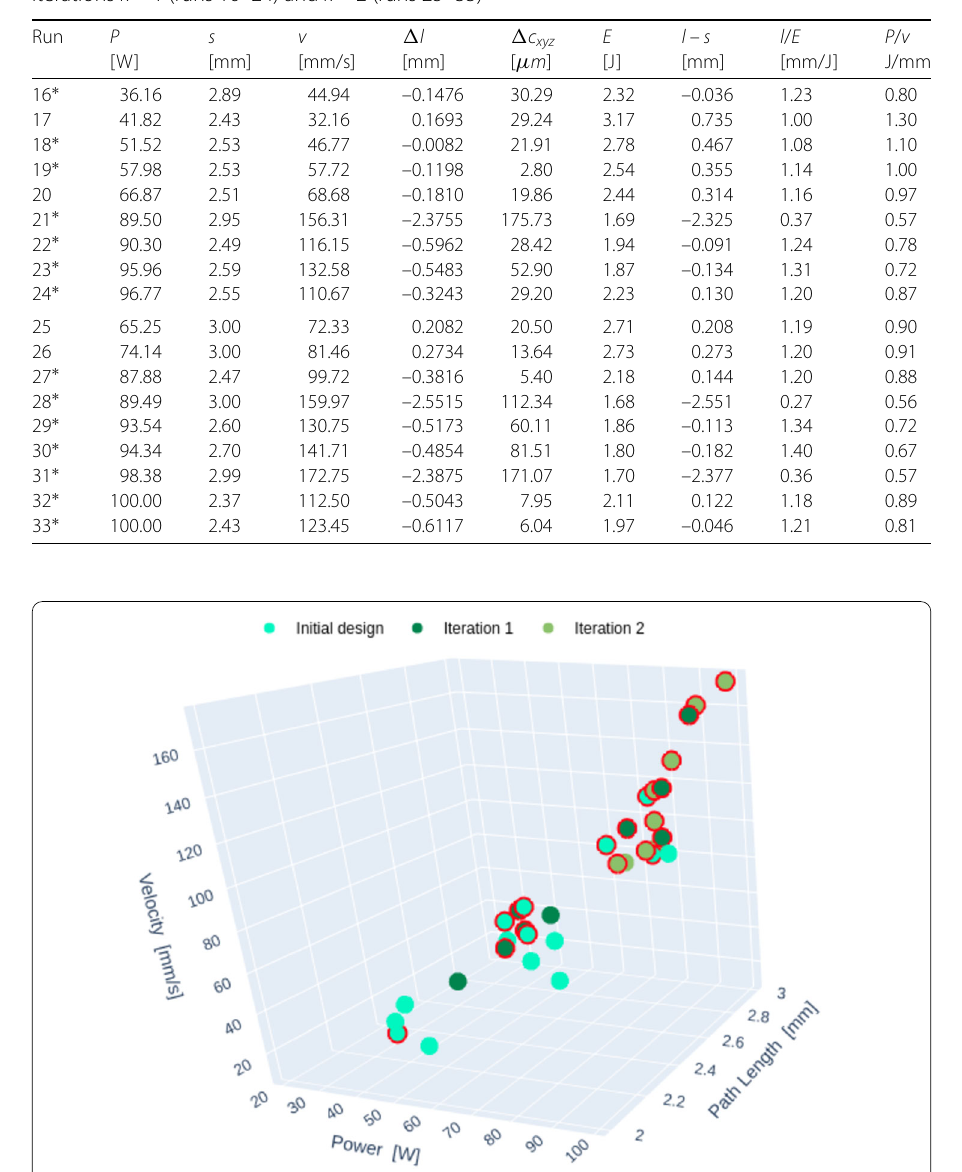
Table 3 Case Study 1: Evaluation of selected predicted Pareto solutions and derived quantities, iterations k = 1 (runs 16–24) and k = 2 (runs 25–33)